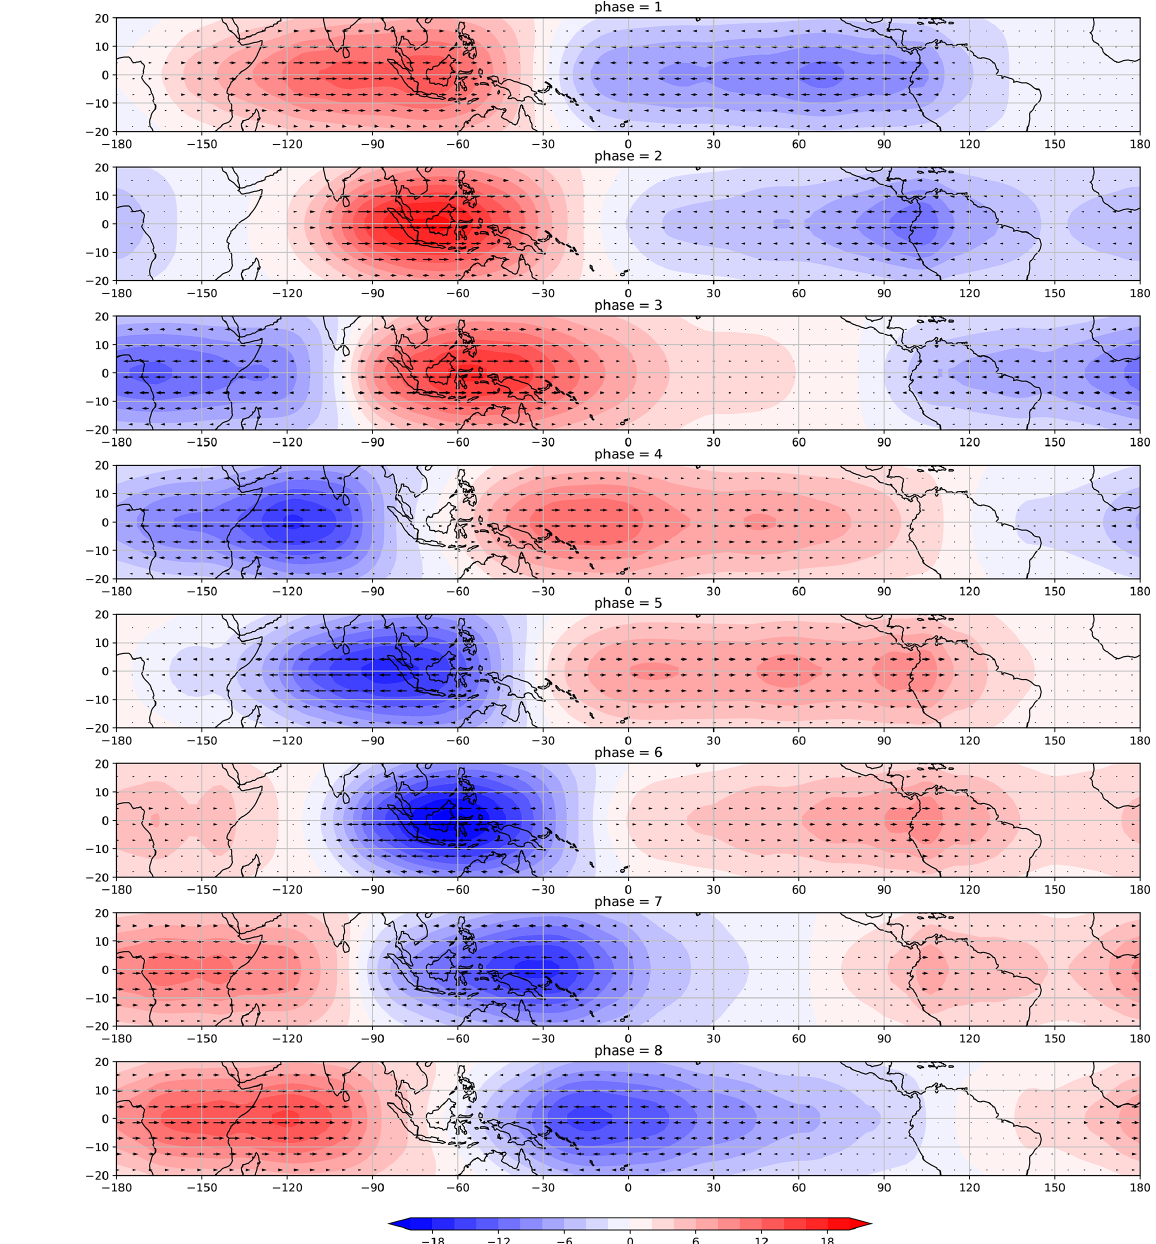
Figure 13. Reconstruction at 200Mb of the velocity and geopotential height fields associated with Kelvin modes with SZW30 −